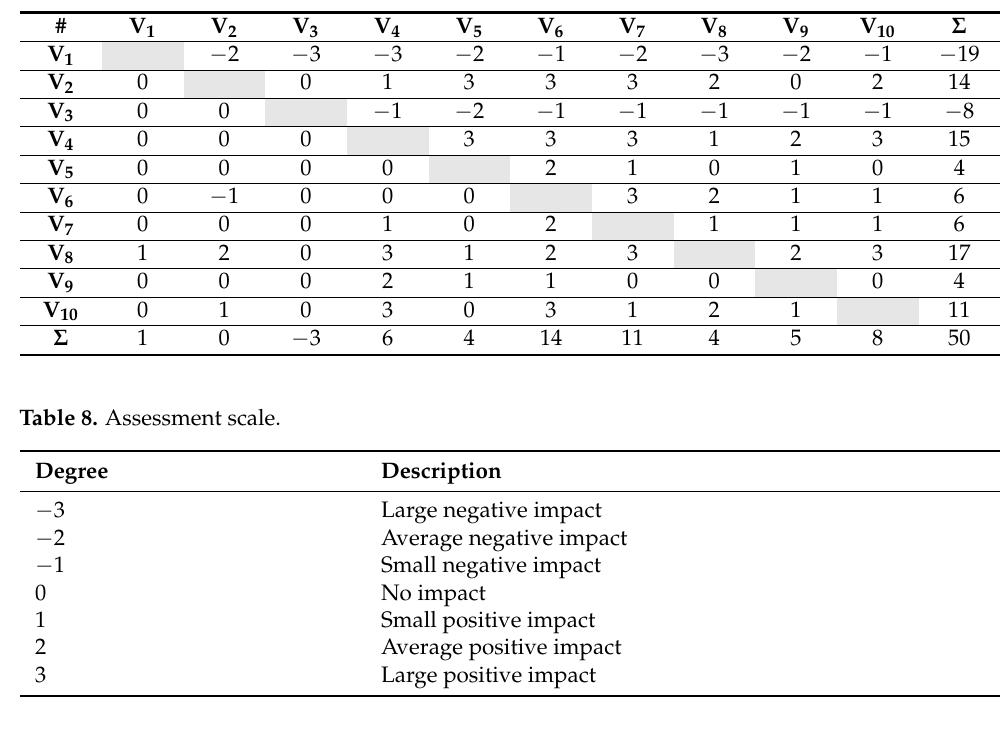
Table 7. Cross-impact matrix.